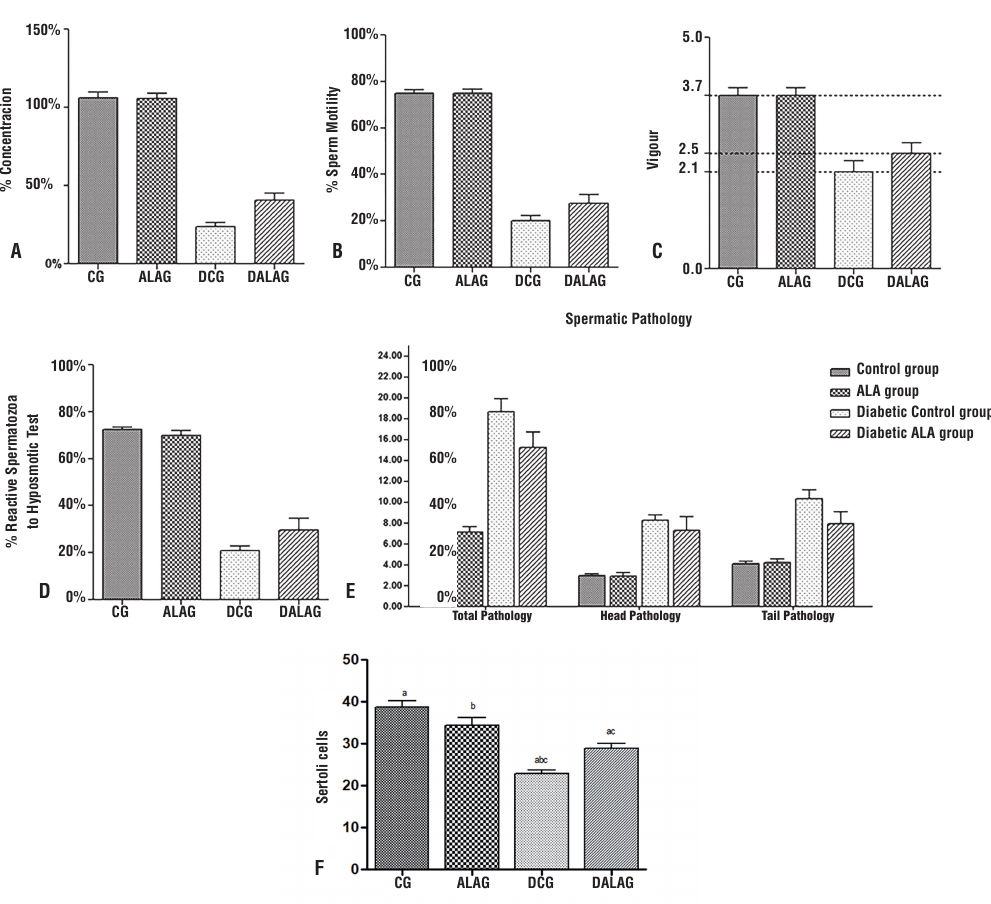
Graph representing the averages of A - Concentration. B - Sperm Motility. C - Vigour. D - Hyposmotic Test and E - Spermatic Pathologies of the normal and diabetic groups after the supplementation of ALA. F - Count of Sertoli cells by seminiferous tubule after labeling with vimentin. DCG presented a reduced mean number of Sertoli cells compared to the other